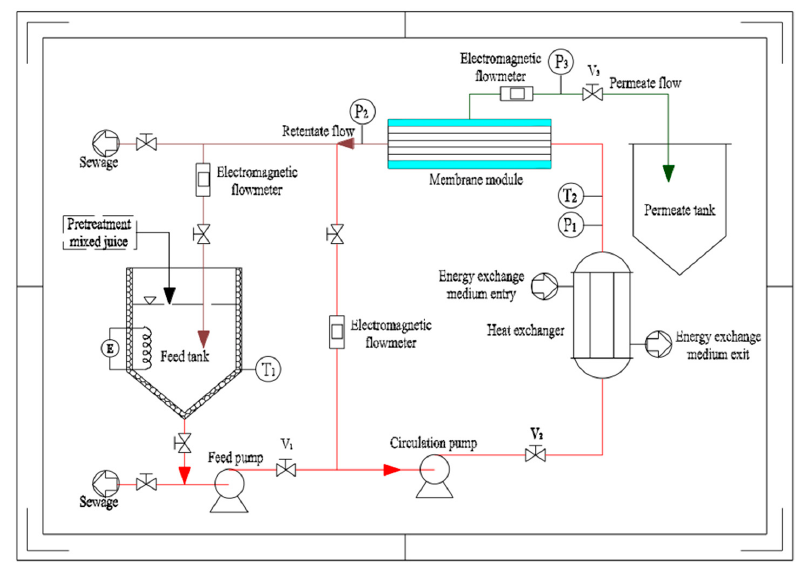
Figure 1. Schematic diagram of the 0.35 m 2 stainless steel membrane experiment device.